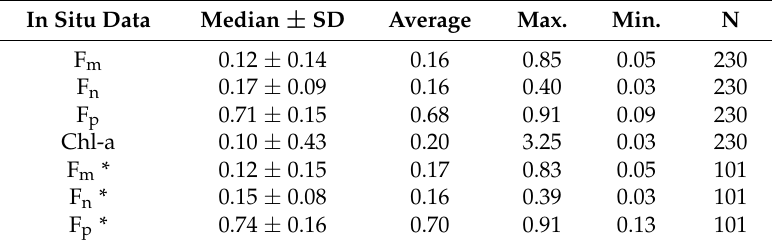
Table 3. Statistics of in situ and matched HPLC datasets. SD, max and min represent the standard deviation, maximum, and minimum values, respectively. The units for Chl-a are mg m − 3 , N is the number of samples. * denotes valid matches for MERIS, MODIS, and SeaWiFS.